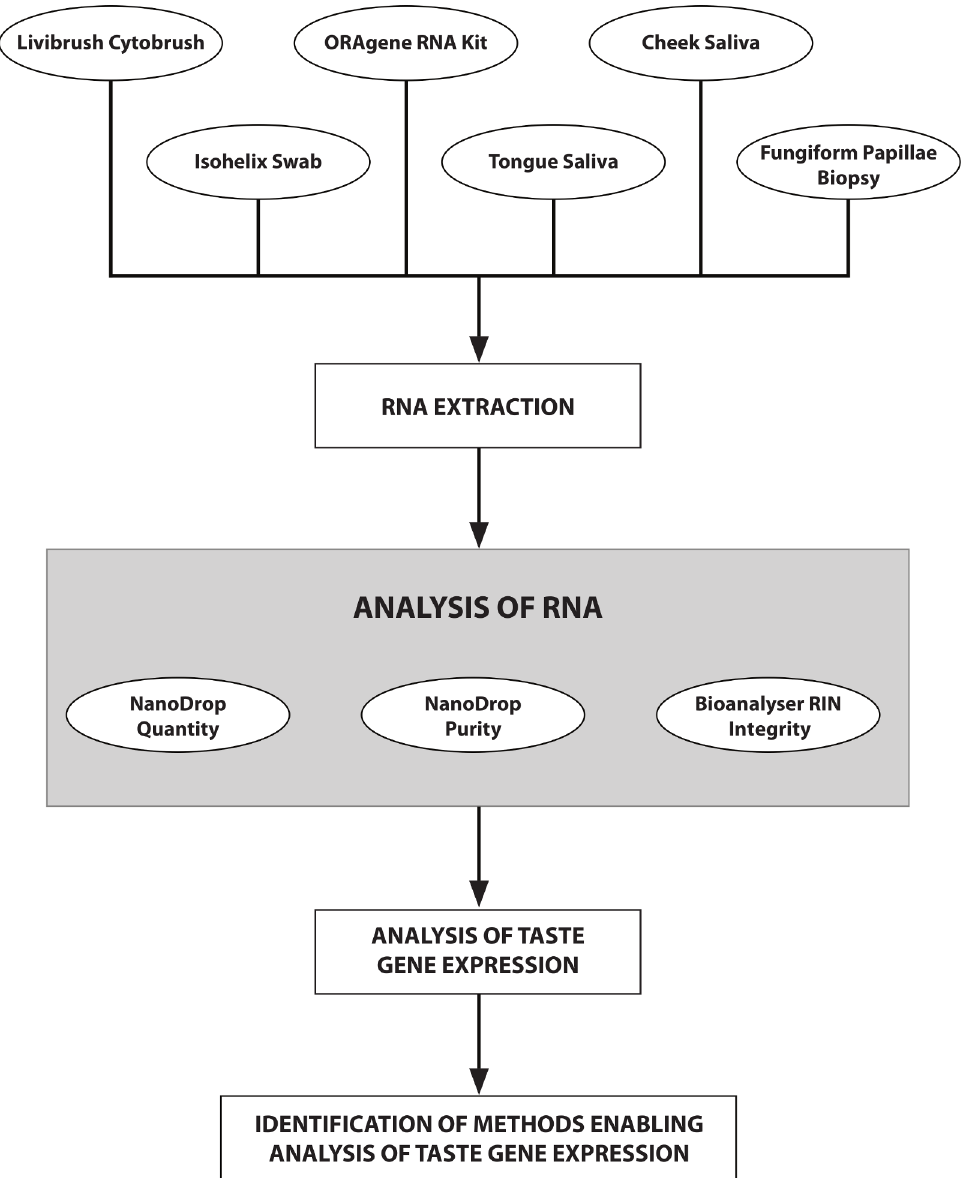
Fig 1. Flowchart of study design to identify collection techniques that enable quantitative measures of taste gene expression. Samples were collected from 8 volunteers using the six different methods, the RNA was extracted and analysed with the NanoDrop ND-1000 Spectrophotometer (for quantity and purity) and Bio-analyser (analysis of RNA integrity). Real-time quantitative PCR was completed on taste tissue markers and taste genes, allowing for the identification of methods enabling quantitative measures of taste gene expression.